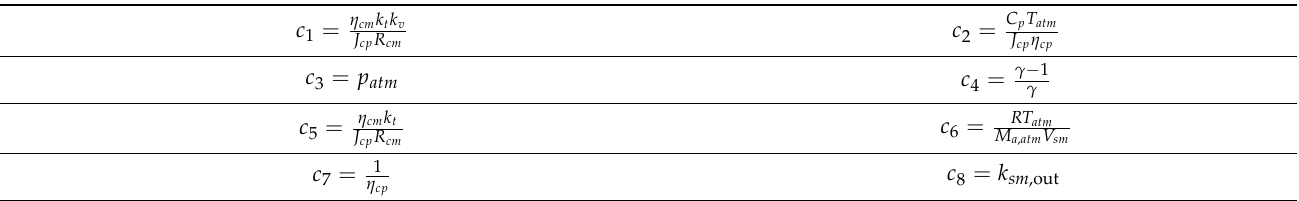
Table A1. The main parameters of the third‑order